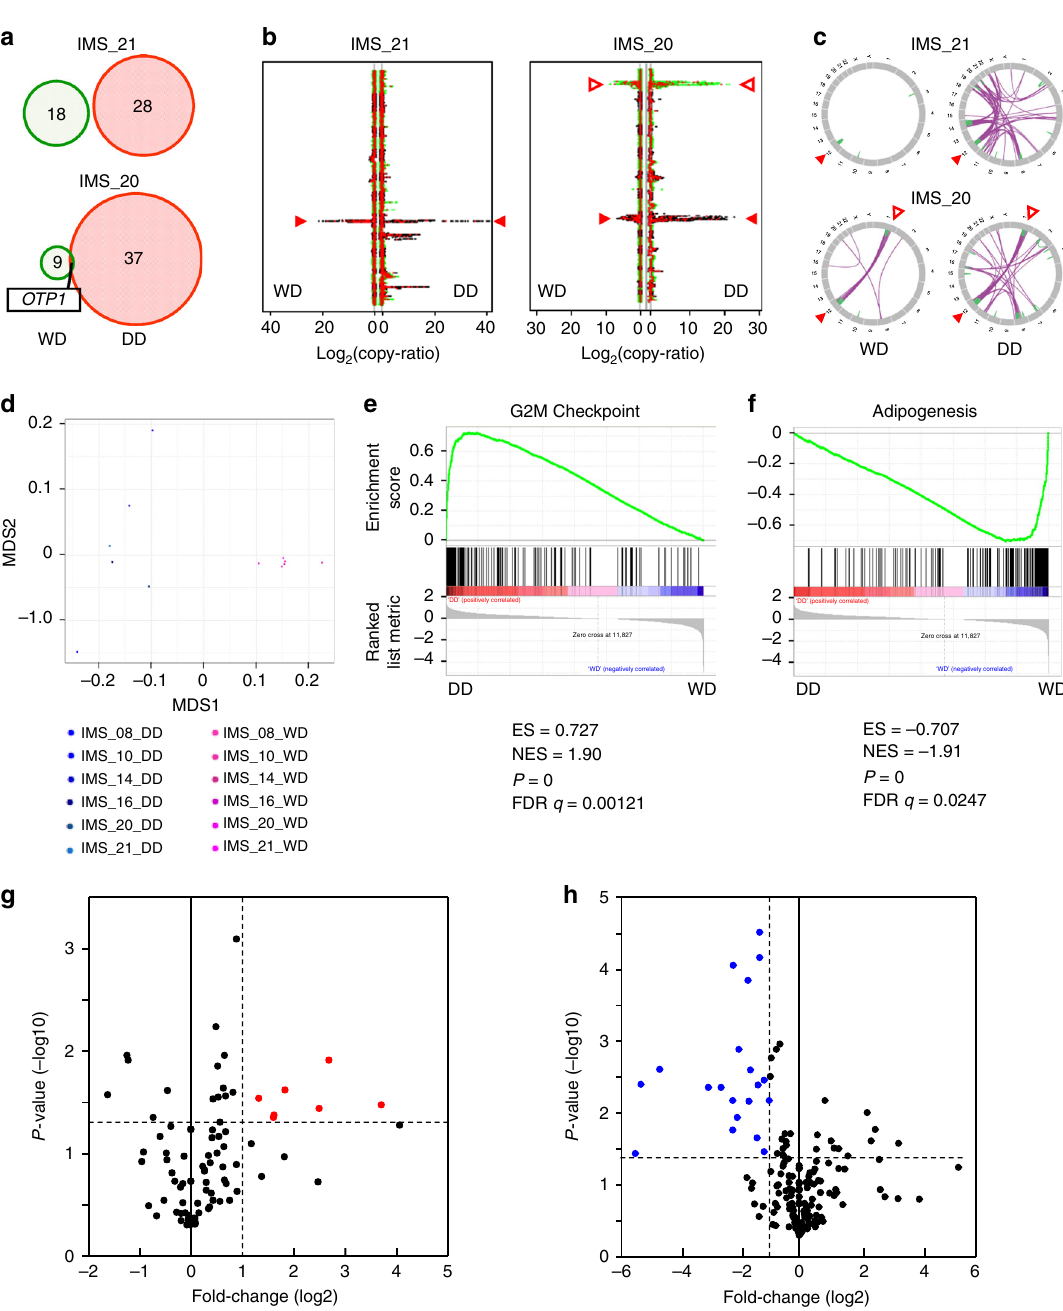
Fig. 4 Comparative analysis of well-differentiated (WD) and dedifferentiated (DD) components from DDLPS. a – c Representative somatic mutations (nonsynonymous SNVs and INDELs) ( a ), SCNAs ( b ), and SVs ( c ) in WD and DD components from the same patients. In a , the circle size and numbers indicate the number of somatic mutations in WD or DD. A boxed gene, OTP1 , indicates a common somatic mutation in the sample. In b , copy numbers were plotted according to the order of the chromosomal regions, from chromosome 1 (top) to 22 (bottom) and chromosome X. Red lines indicate segmented exome circular binary segmentation calls. The segmentation size is based on the exome capture kit bed fi le. Solid arrows indicate 12q15; empty arrows indicate 1p32.1. In c , two representative cases are presented, with others presented in Supplementary Fig. 9. d Multidimensional scaling analysis of expression pro fi les of paired WD and DD. Six pairs of WD and DD were analyzed. e , f GSEA analysis comparing the expression pro fi les of DD and WD. The gene sets most enriched in DD ( e ) and WD ( f ) are shown. g , h Volcano plots of the DD-speci fi c gain ( g ) and loss ( h ) of genes. The red and blue dots denote large magnitude fold-changes (more than 2 or less than ½; horizontal axis) and high statistical signi fi cance (more than 1.301 of − log 10 of P -value by one-sided paired T test; vertical axis),